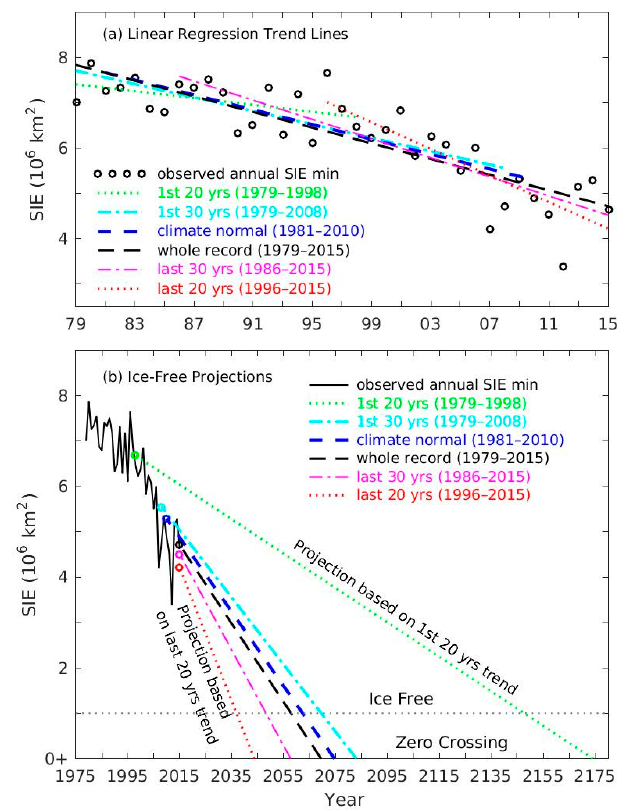
Figure 3. ( a ) Linear regression trend lines based on different subsets of the annual Arctic SIE minimum time series; and ( b ) Arctic ice-free projections based on these linear trends. The annual Arctic SIE minimum values from five-day moving average based on daily sea ice concentrations are denoted by black circles in ( a ) and black solid line in ( b ). Different color and line styles in ( a , b ) denote the linear regression trend lines and the FIASY projections based on the linear trends for the period of first 20 years (1979–1998; green dotted), first 30 years (1979–2008; cyan dash-dotted), climate normal period (1981–2010; thick blue dashed), all 37 years (1979–2015; black dashed), last 30 years (1986–2015; magenta dash-dotted), and last 20 years (1996–2015; red dotted), respectively. Open circles in ( b ) denote the end of data fitting and the start of the projection. The horizontal black dotted line in ( b ) denotes the ice-free threshold of one million square kilometers. The zero-crossing of Arctic SIE minimums is denoted by “0+”, which represents a state in this analysis that all data grid cells in the Arctic Ocean have less than 15% sea ice area fraction.